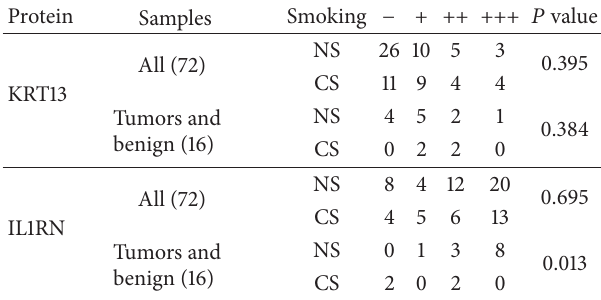
Table 3: Correlations between KRT13 and IL1RN expression and smoking status among all samples and a subset from patients providing both tumor and control samples (only CS and NS were